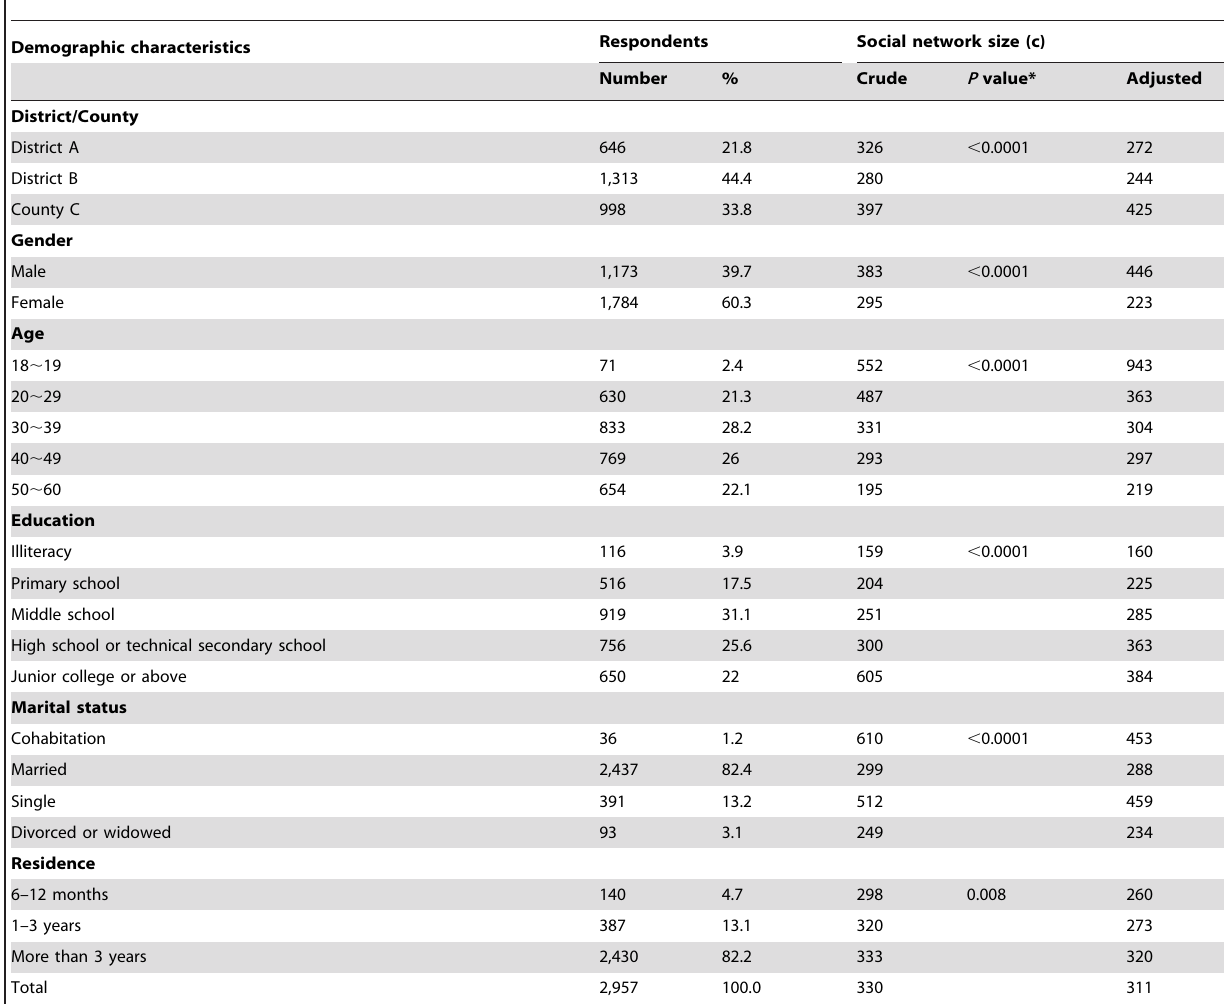
Table 2. Average social network size by demographic characteristics, Chongqing, China (2011).